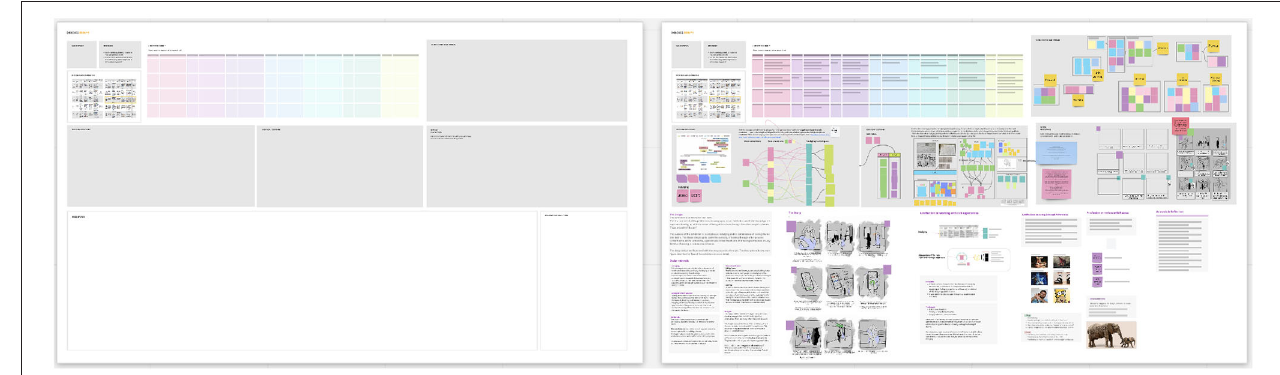
FIGURE 6 | Screenshot of a Miro board with an empty template for an exercise, and a filled exercise board by a group of students. The aim of this figure is to show the overall aspect of an exercise template, and visually contrast its empty state with a populated state. The content is therefore not